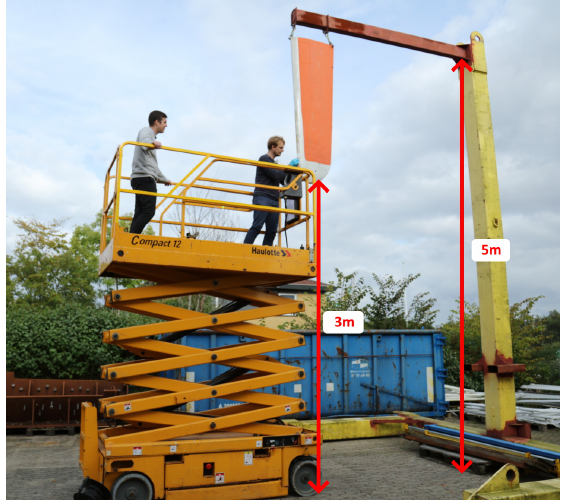
Figure 1. The wind turbine blade segment positioned on the built gantry, together with the scissor lift used for capturing image and replica